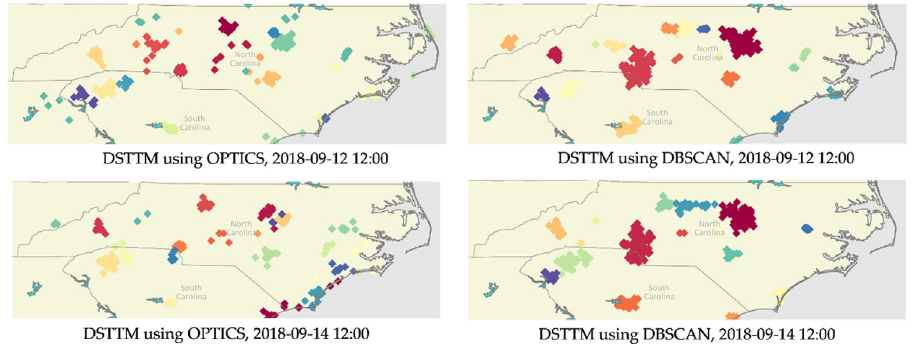
Fig. 7 Comparison between dynamic spatio-temporal tweet mining (DSTTM) using ordering points to identify the clustering structure (OPTICS) and density-based spatial clustering of applications with